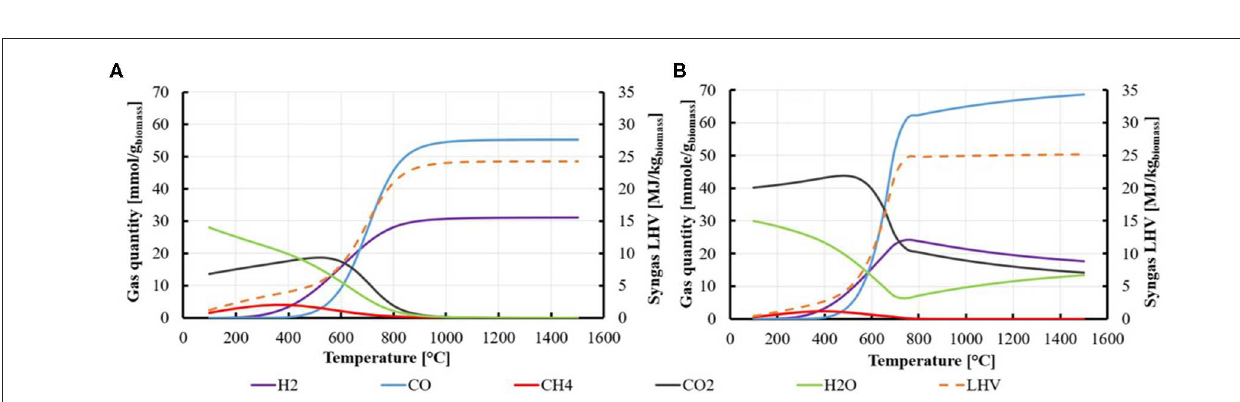
FIGURE 2 | Quantity of gases produced at thermodynamic equilibrium per gram of dry biomass from gasification of wood with carbon dioxide according to temperature: (A) stoichiometric proportion C 6 H 9 O 4 + 2CO 2 ; (B) over-stoichiometric proportion C 6 H 9 O 4 + 6CO 2 .